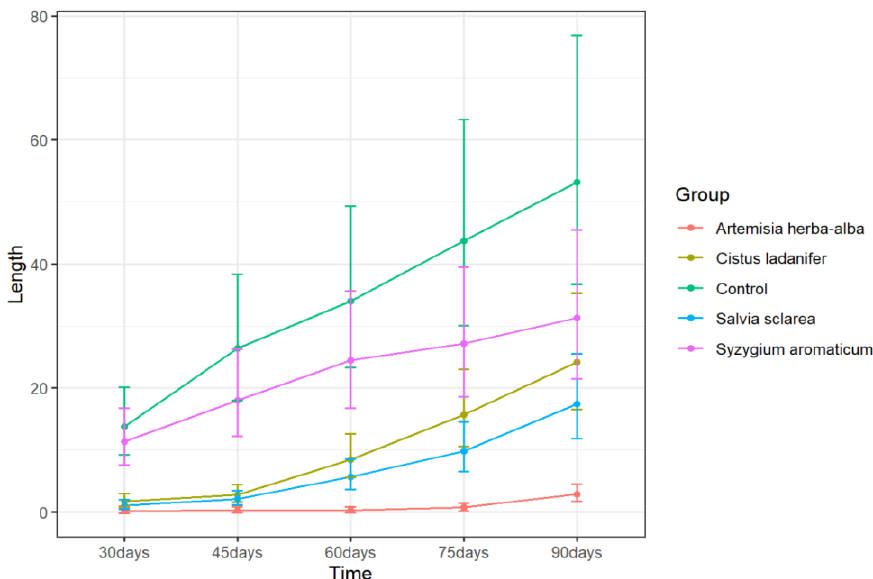
Figure 1. Sprout length (mm) over time of potatoes treated with distilled water (control), and the most effective EO treatments including A. herba-alba , C. ladanifer , and S. sclarea EOs, and Syzygium EO treatment. Error bars represent the 95% confidence level of the back-transformed means ( emmeans method ). Table 3. A. herba-alba EO constituents determined via GC—MS—FID analysis.